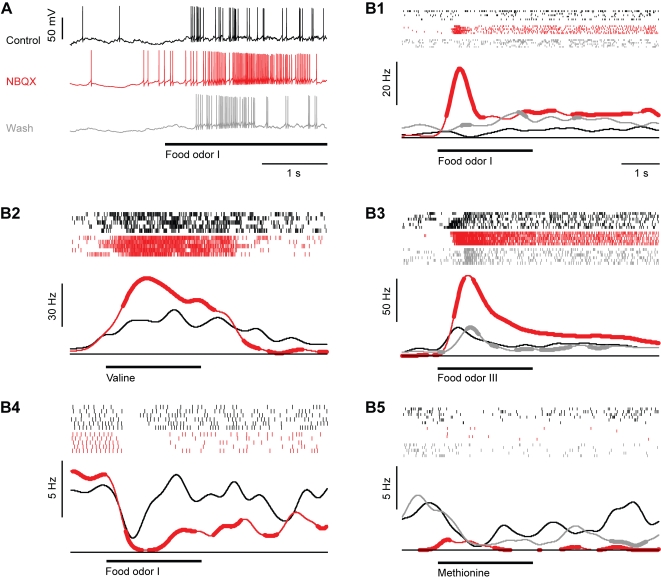
Effect of the AMPA/kainate receptor antagonist, NBQX, on odor responses of mitral cells.(A) Whole-cell recording of a mitral cell response to odor stimulation (food extract; bar) before (black) and during (red) bath-application of NBQX and after washout (gray). (B1–B5) Five examples illustrating effects of NBQX on odor responses. Ticks denote individual action potentials. Each row shows one trial. Black: control; red: during NBQX application; gray: after wash-out of NBQX. Continuous lines are peri-stimulus time histograms, averaged over all trials under each condition. Thick portions depict time bins where peri-stimulus time histograms were significantly different (Student's t-test; P<0.05) from the corresponding time bin in the control peri-stimulus time histogram (black). Bar indicates odor stimulation. Responses are from different cells and were recorded in the whole-cell, cell-attached or loose-patch configuration.